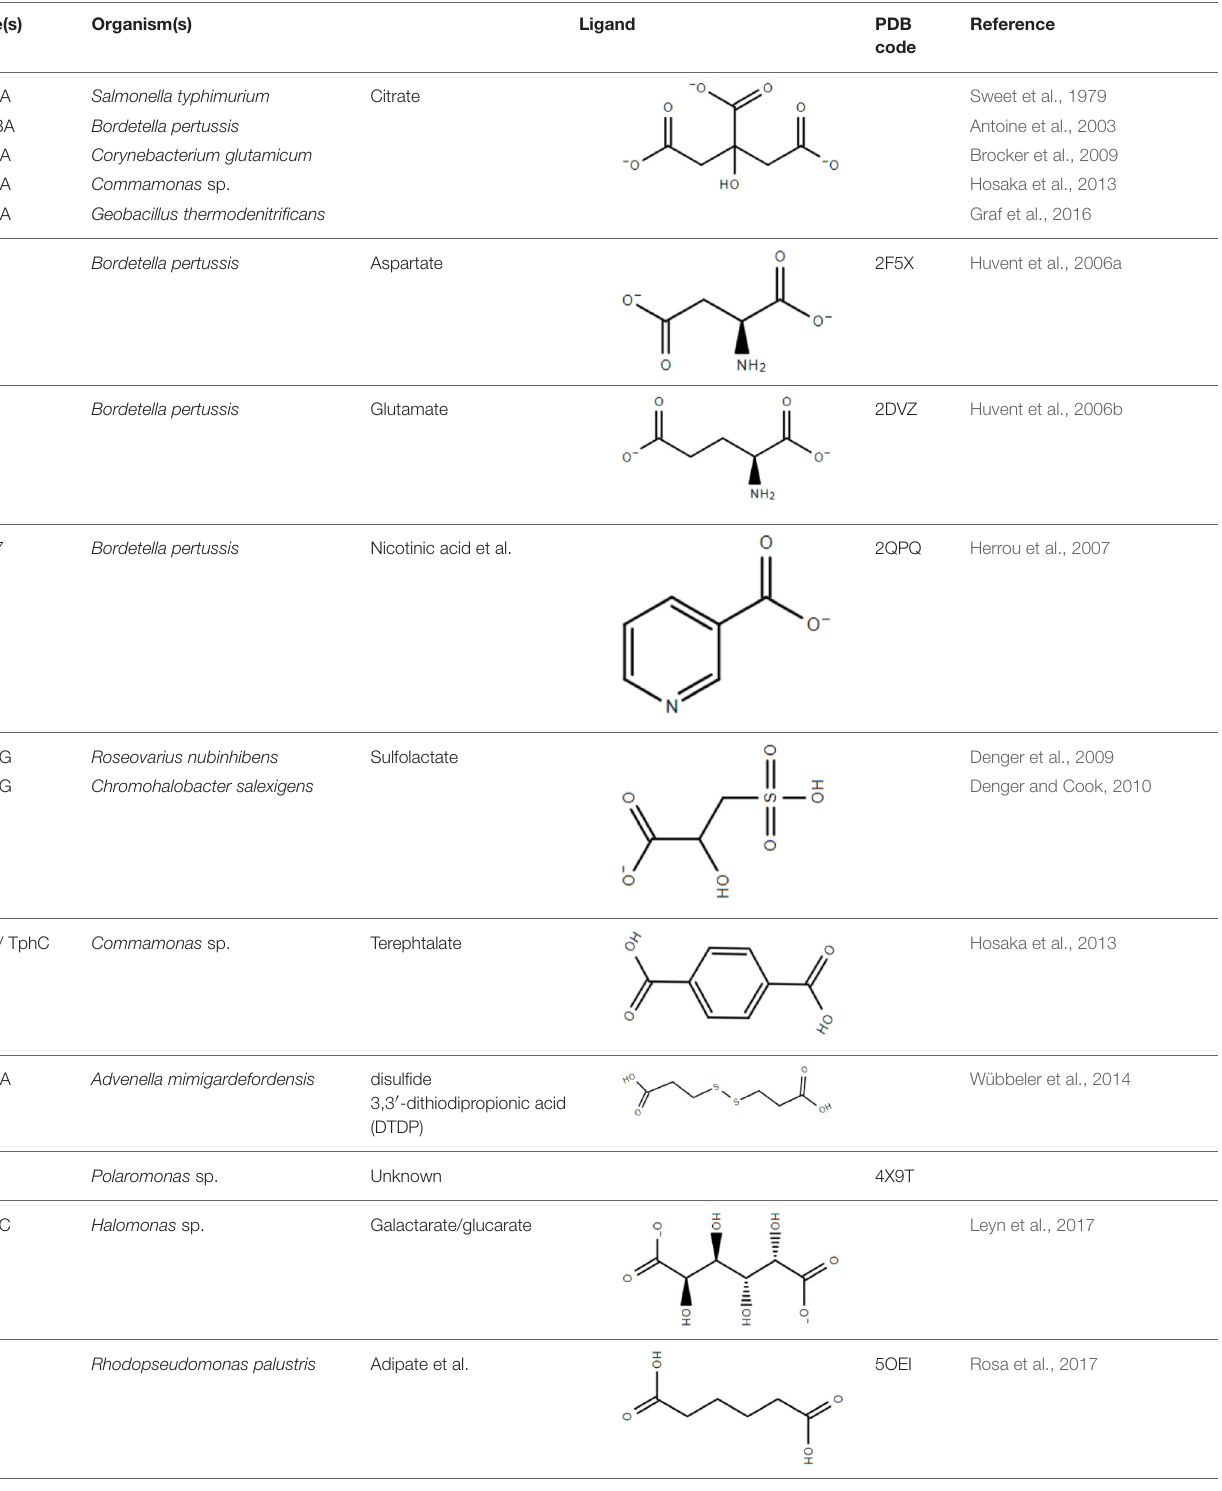
TABLE 1 | Experimentally characterized TTT transporters and